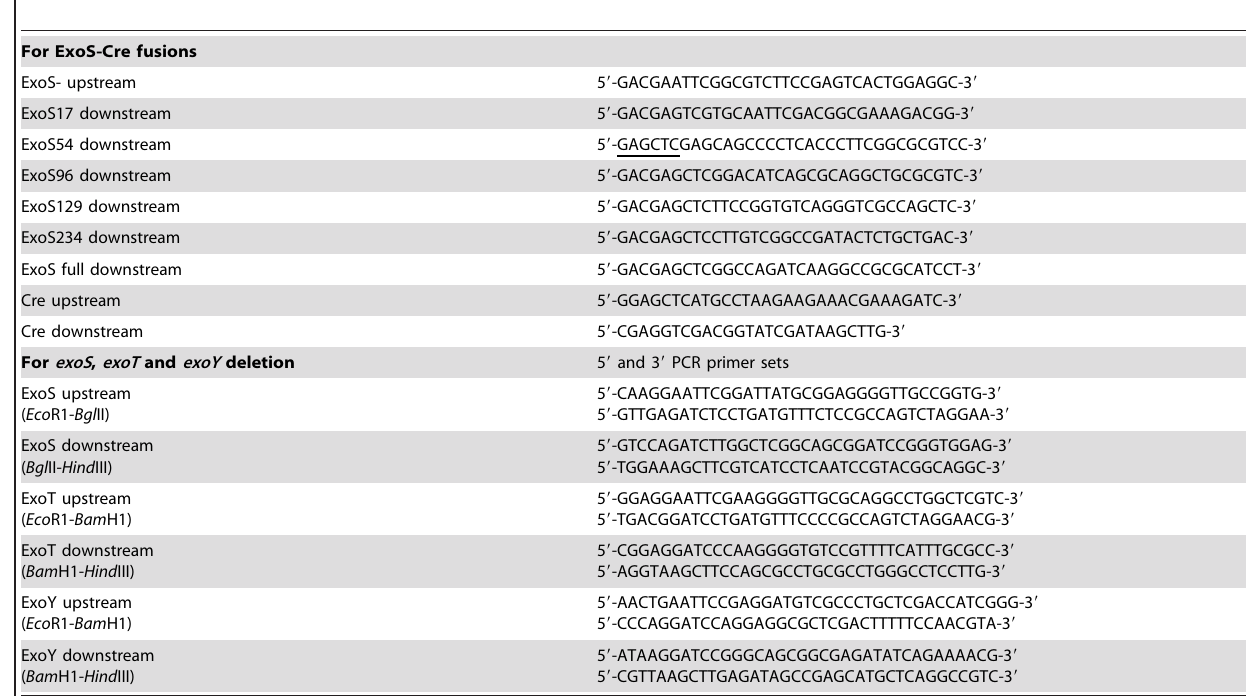
Table 2. PCR primers used in this